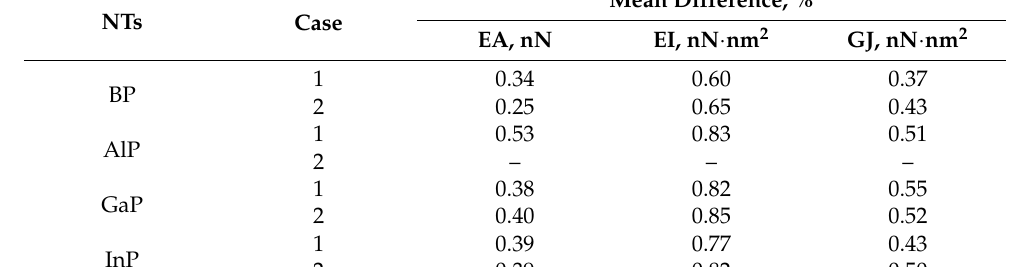
Table 7. MeandifferencebetweentherigidityvaluesofSWBPNTs, SWAlPNTs, SWGaPNTsandSWInPNTs evaluated with Equations (33)–(35) and the corresponding values obtained from the FE analysis.